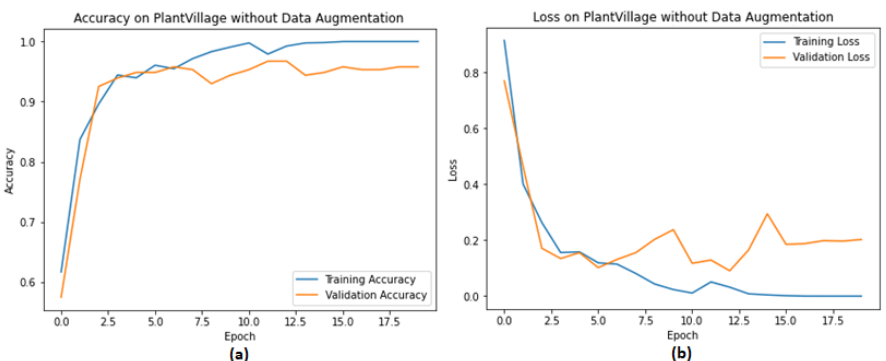
Figure 17. ( a ) Accuracy graph of PDDCNN on PlantVillage without data augmentation. ( b ) Loss graph of PDDCNN on PlantVillage without data augmentation.